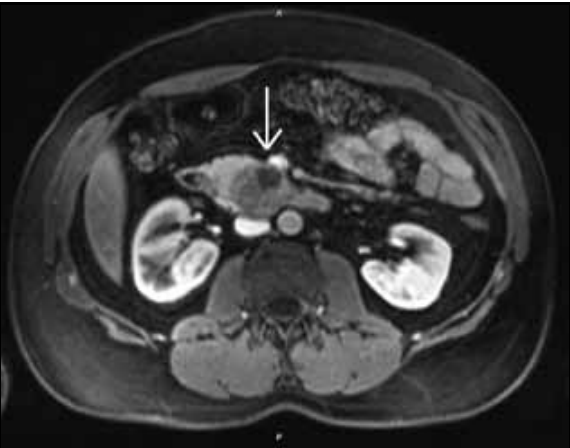
Figura 2 – RM: corte axial ponderado em T1 após contraste mostra lesão sólido-cística no processo uncinado RM: ressonância